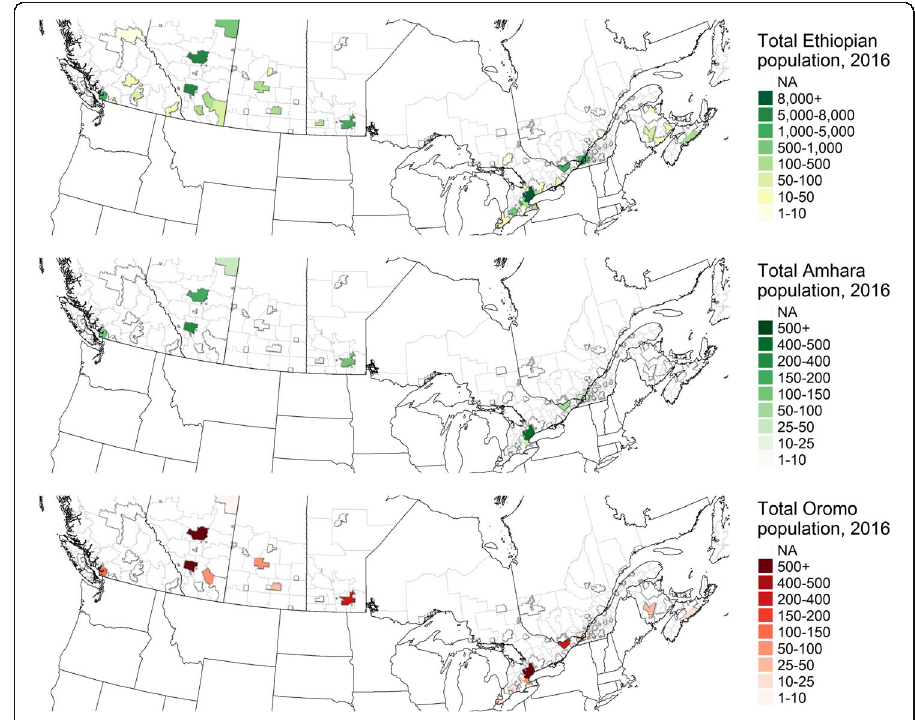
Table 2 Proportion of ethnicity to birth for groups from the Horn of Africa, 1996 – 2016 censuses Country of ancestry/birth Year N (CSDs or CMAs) Mean proportion, Median proportion ethnicity to birth Ethiopia 1996 25 1.776 1.702 2001 31 1.029 1 2006 43 1.1017 1 2011 21 1.198 1.168 2016 66 1.133 1.119 Eritrea 1996 NA NA NA 2001 25 1.314 1.286 2006 25 1.533 1.649 2011 NA NA NA 2016 45 1.43 1.5 Kenya 1996 NA NA NA 2001 60 0.203 0.079 2006 64 0.222 0.049 2011 26 0.546 0.521 2016 72 0.435 0.327 Somali 1996 26 1.545 1.574 2001 27 1.375 1.409 2006 36 1.628 1.802 2011 NA NA NA 2016 39 1.986